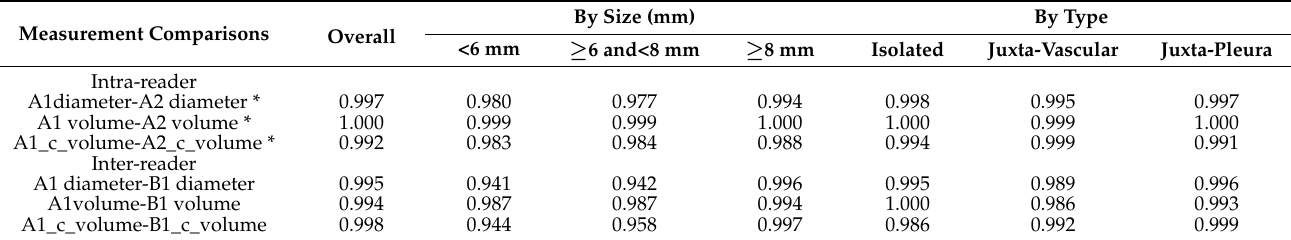
Table 3. Intra-reader and inter-reader measurements.